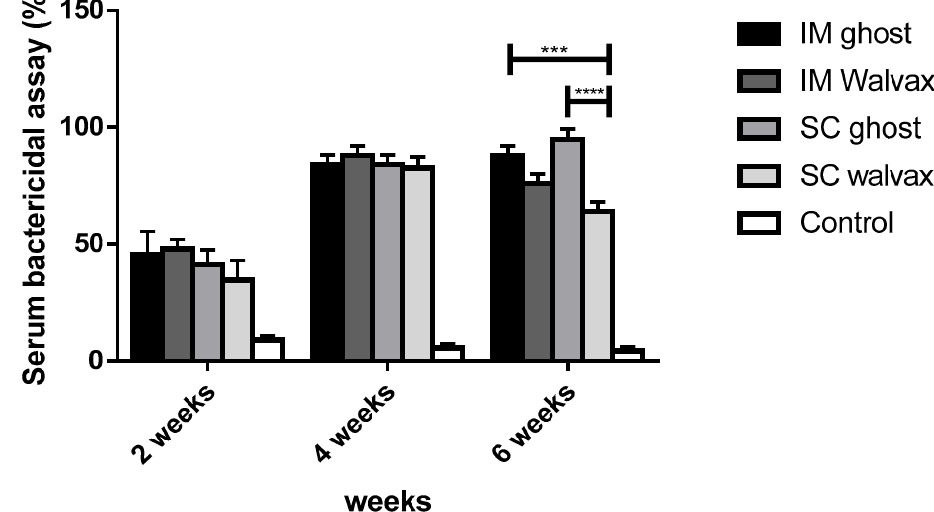
Figure 10. Serum bactericidal activity of rats vaccinated with NmC-BG and commercial meningococcal vaccine. A bar chart showing serum bactericidal activity in rats immunized with BG vaccine and commercial meningococcal vaccine through intramuscular and subcutaneous routes against PBS (control). The bactericidal activity of the serum was determined after incubation with the N. meningitidis strain for 1 h. Error bars represent the standard deviation from the mean. *** indicates significance with p < 0.001 and **** indicates significance with p <